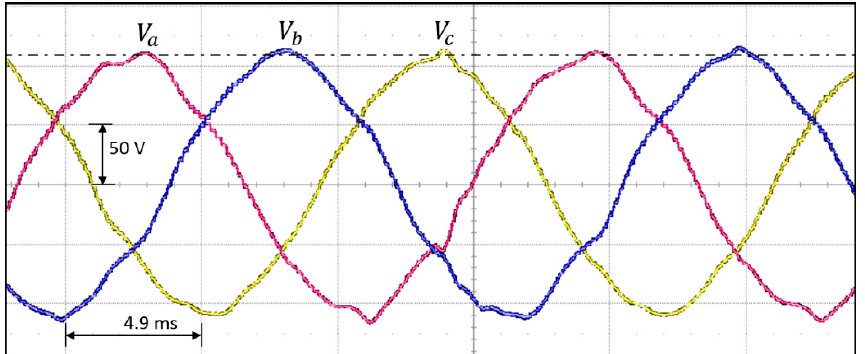
Figure 12. The steady state response of the three-phase output voltages with MPC-DOB under the